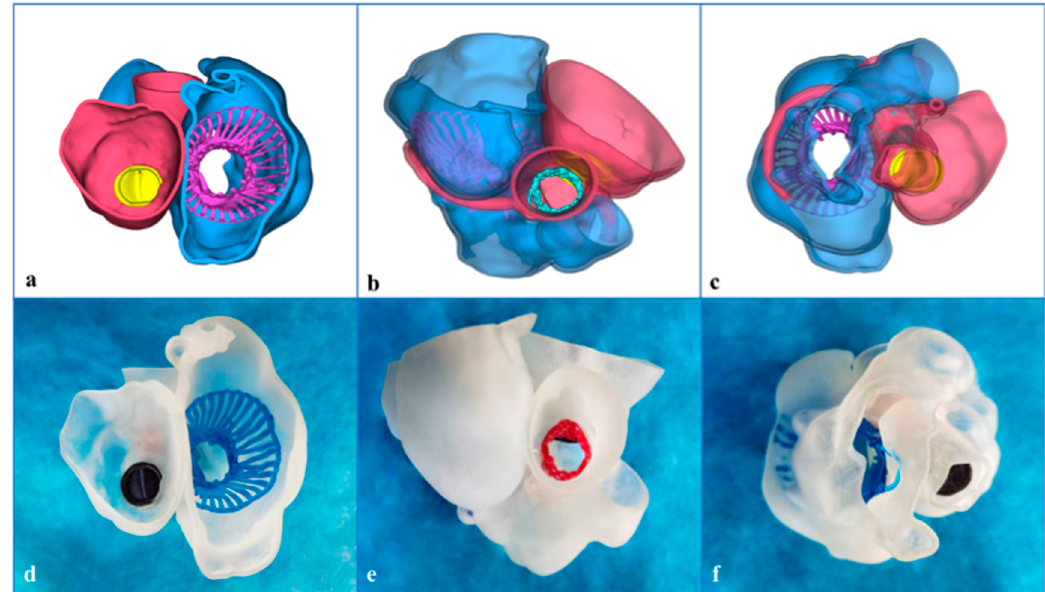
Figure 5. The 3-dimensional (3D)-printed model after the procedure verified the position of the stented valve. In the 3D reconstruction images, the right atrium and right ventricle are blue; the left atrium and the left ventricle are red; the mechanical mitral valve is yellow; the aortic valve stent is green; and the LuX-Valve stent is purple. However, in the 3D-printed model, the mechanical mitral valve is black, the aortic valve stent is red, and the LuX-Valve stent is blue. ( a ) Three-dimensional reconstruction image from the right atrial view; ( b ) 3D reconstruction image from the lateral view; ( c ) 3D reconstruction image from the right ventricular view; ( d ) the 3D-printed model from right atrial view; ( e ) the model from the lateral view; ( f ) the model from right ventricular view.